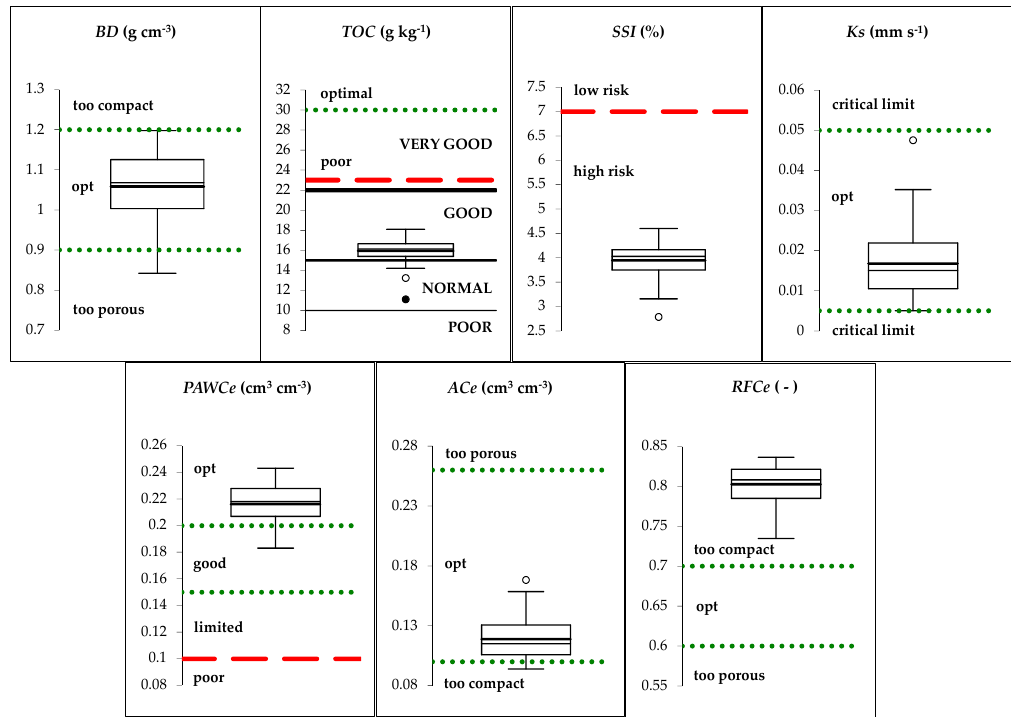
Figure 3. Box plots of dry bulk density ( BD ), total organic carbon content ( TOC ), structure stability index ( SSI ), saturated hydraulic conductivity ( Ks ), plant available water content ( PAWC ), air capacity ( AC ) and relative field capacity ( RFC ). The thick-black line within each box represents the mean value (the fine-black line, the median). Open circles represent outliers (closed circle, extreme outlier for TOC ). Dot green-line or dashed red-line represents optimal or critical values, respectively, according to Section 2.3. For TOC , a further classification by Sequi and Nobili [43] was specifically reported (solid lines, which identify four areas, from poor to very good) for fine textured soils (clay, clay-loam, silty-clay and silty-clay-loam, according to